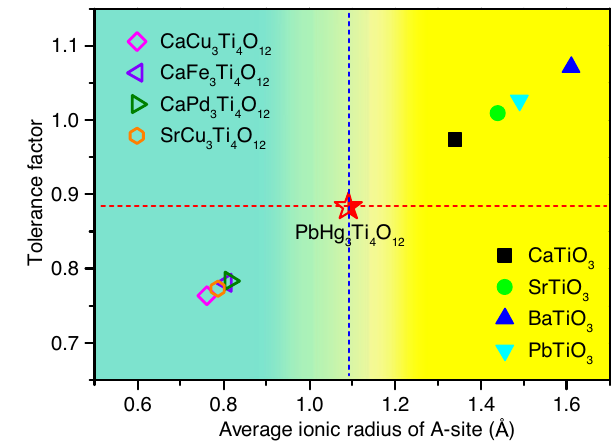
Fig. 2 Tolerance factor t versus average ionic radius of A-site for simple perovskites ATiO 3 and A-site-ordered perovskites AA ′ 3 Ti 4 O 12 . Upper right panel is the area for simple ATiO 3 perovskites; Lower left panel is the area for AA ′ 3 Ti 4 O 12 perovskites; The middle point